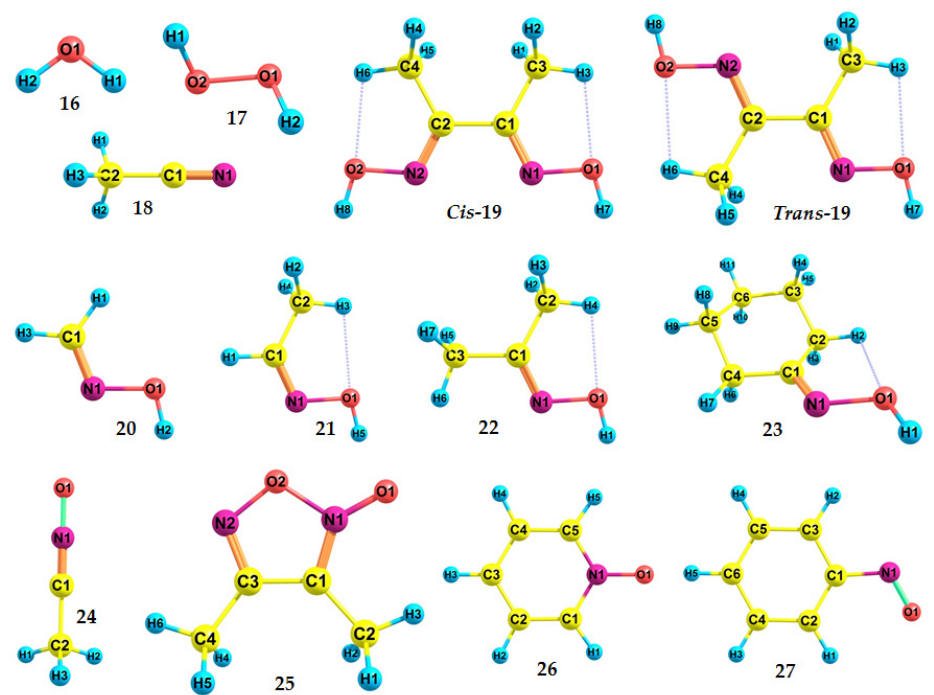
Figure 10. DFT calculated structures of the components of the reaction mixture, related molecules and possible oxidation products. Table 5. Experimental and DFT calculated adiabatic ionization potential (AIP, eV) and DFT calcu-